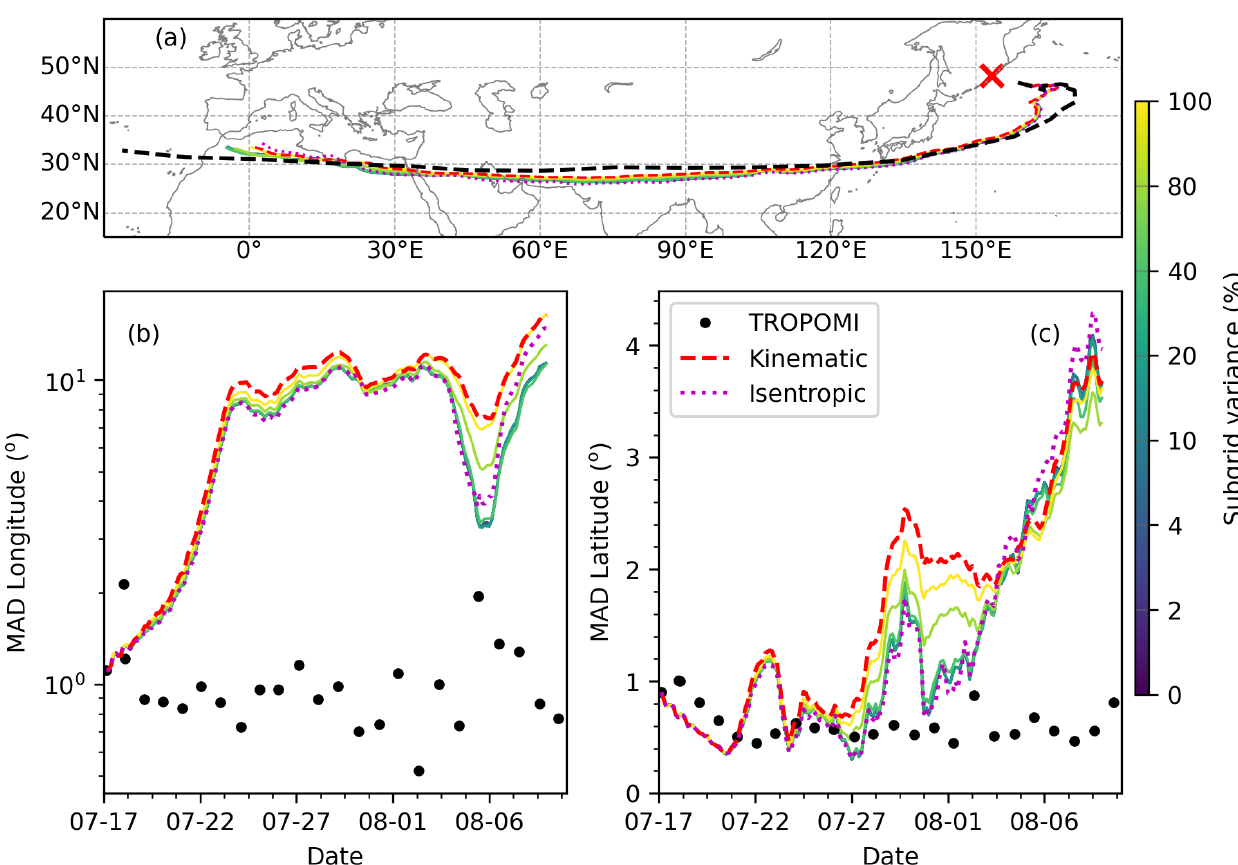
Figure 17. Trajectories (a) and degree of dispersion (b) in the longitude dimension and (c) in the latitude dimension of the AC SO 2 cloud in simulations driven by vertical velocity but with different subgrid-scale diffusion settings (see color bar). Results from TROPOMI data are shown in black. Results from the simulations (diffusion module is set to default in both simulations) with vertical motion driven by vertical velocity and potential temperature are shown in red and magenta,